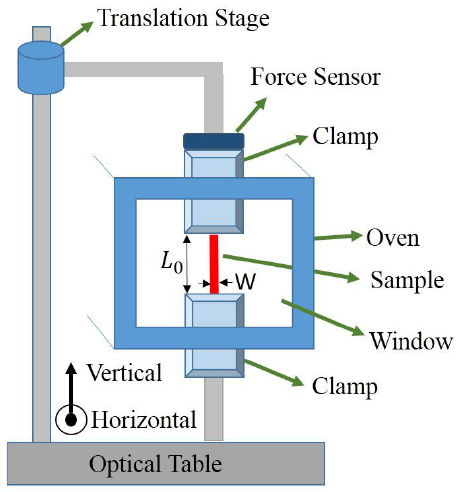
Figure 2. Force measurement